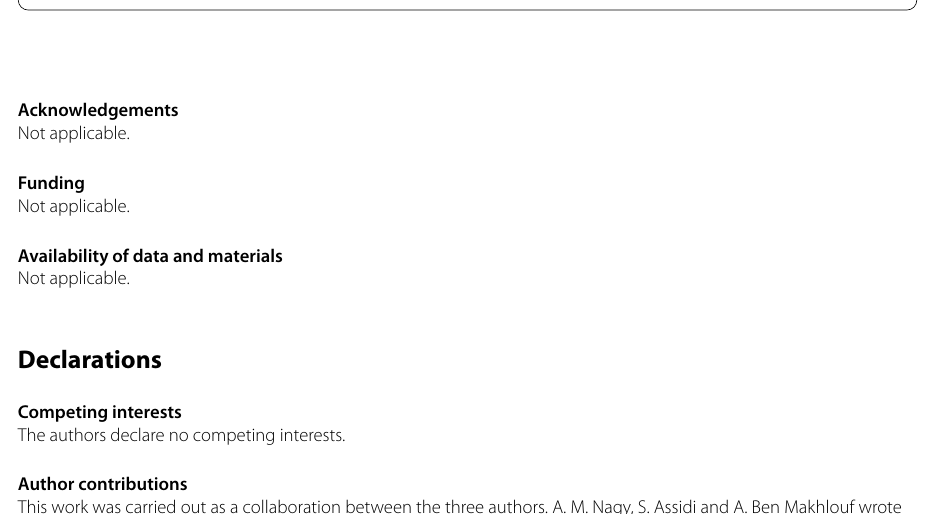
Figure 4 The approximate values of p ( t ) for the perturbed basic cobweb model, Example 2, at various values of ρ and α = 0.7